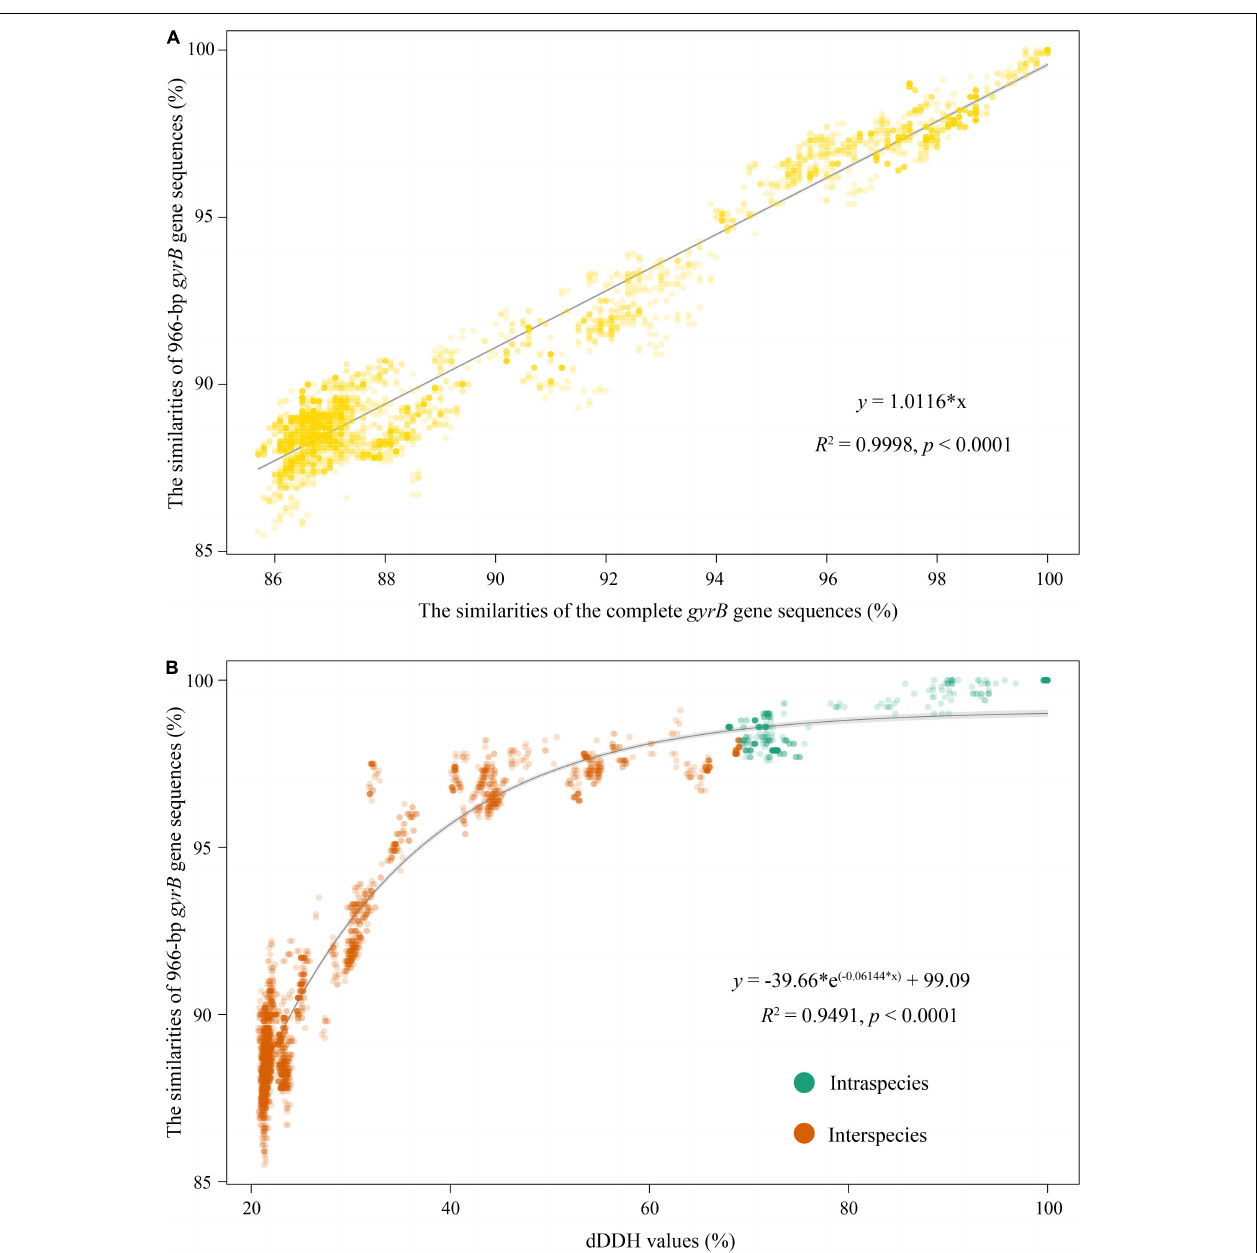
FIGURE 3 | Correlation analyses of identities between the complete gyrB gene sequences and 966-bp gyrB ones (A) , and the dDDH values and the 966-bp gyrB gene sequence identities (B) . Correlation analyses of the former and latter were, respectively, simulated using the Excel linear regression and “exp3P” model of the “basicTrendline” library in